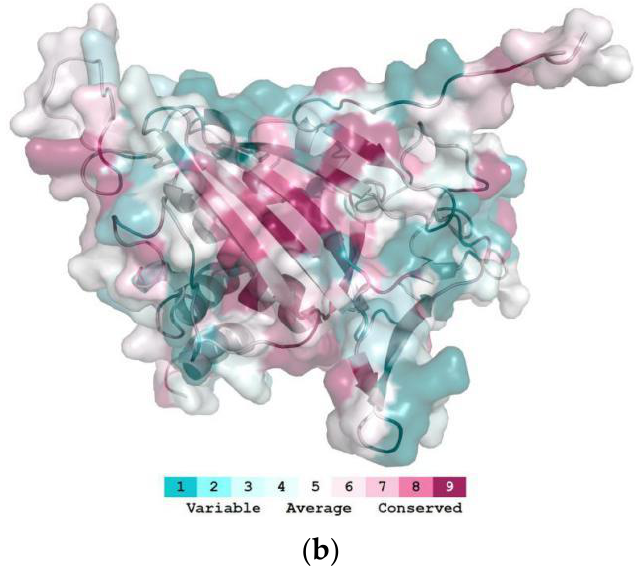
Figure 3. Three-dimensional molecular structure of CmdsRNase. ( a ) This graphic was drawn using PyMOL 2.5 based on the CmdsRNase.pdb data. Red represents α -helices, yellow indicates β -pleated sheets, and green denotes random coils. S208 and N297 indicate O- and N-glycosylation, respectively. ( b ) The highly conserved region (in deep red) is displayed in the structure. The homology model was performed by the ConSurf software (https://consurf.tau.ac.il) (accessed on 20 December 2021) and optimized using PyMOL 2.5.